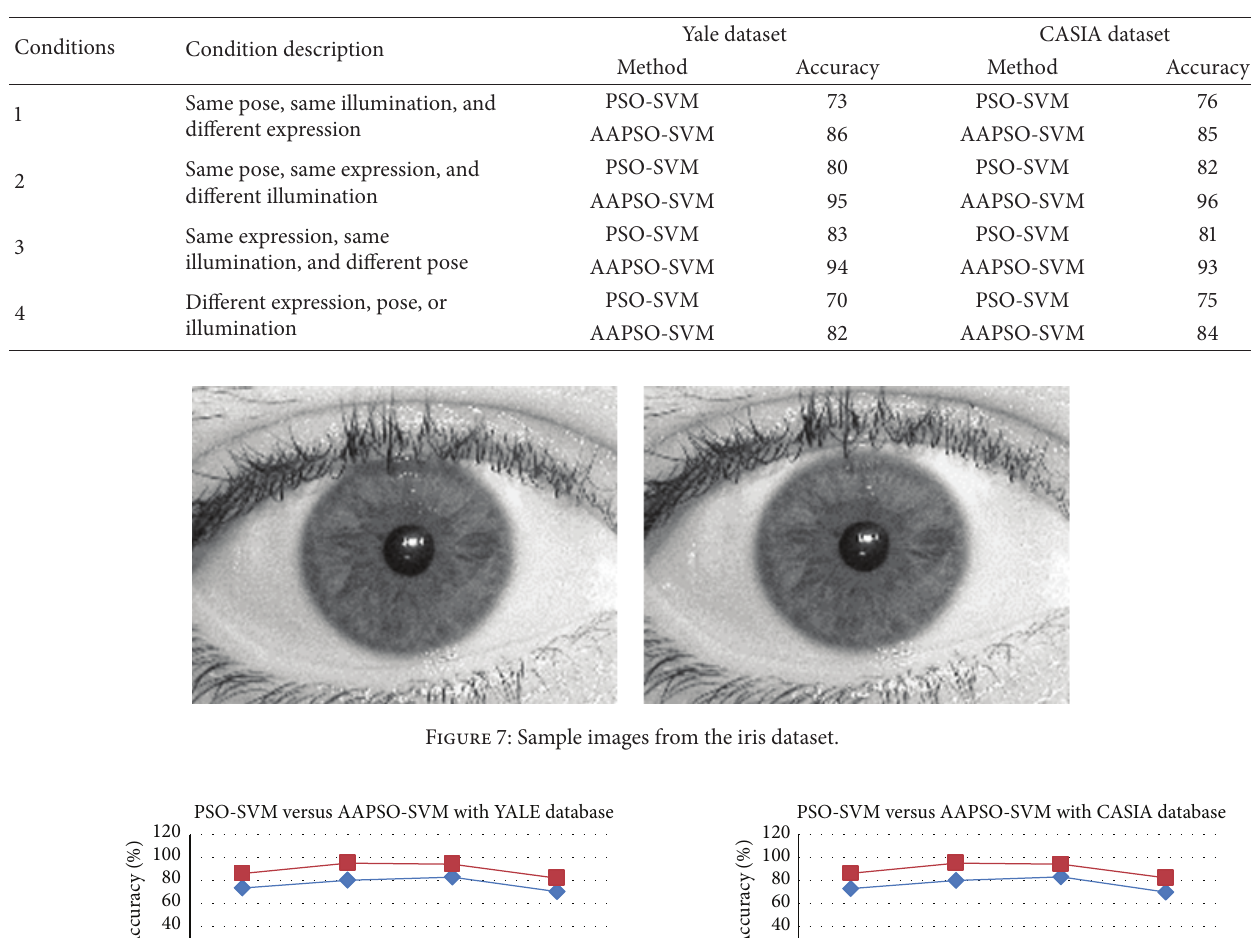
Table 2: Accuracy values of the proposed AAPSO-SVM and the PSO-SVM techniques with face datasets.